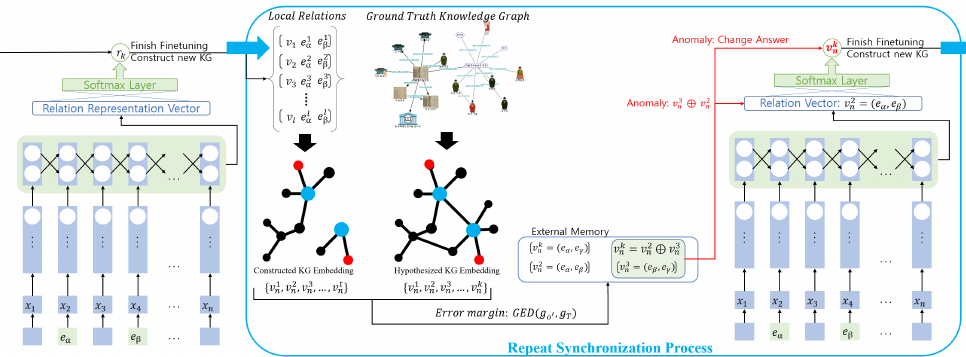
Figure 2. Singular Cycle of Synchronization process: Once the Local Relation Extraction module is trained, a full document is given as input sentence by sentence. The Local Relation info is then used to create a Knowledge Graph(KG). The constructed KG is then compared to a ground truth KG paired with the document. Both KGs are embedded based on the current LR representations. Any incorrect/missing relations within the constructed KG is stored in an external memory. As the fine-tuning of the local relation extraction module begins again, whenever a component from the external memory is detected, any paired vector representations are concatenated to it as well, allowing it to fine-tune against the incorrect/missing relations as well. The process aims to minimize the error margin between the two KGs that can be measured by graph edit